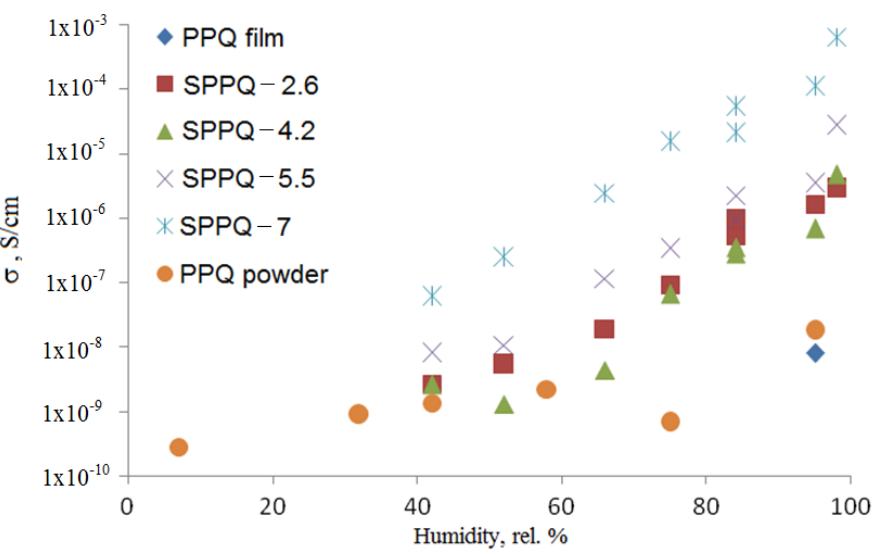
Figure 13. Dependence of the proton conductivity of PPQ and SPPQ film samples on the ambient humidity.